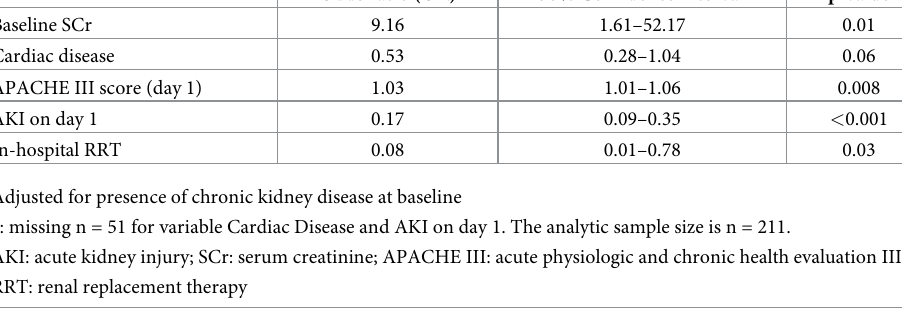
Table 4. Factors associated with recovery of renal function after AKI in survivors to hospital discharge (n = 262 + ). Odds ratio